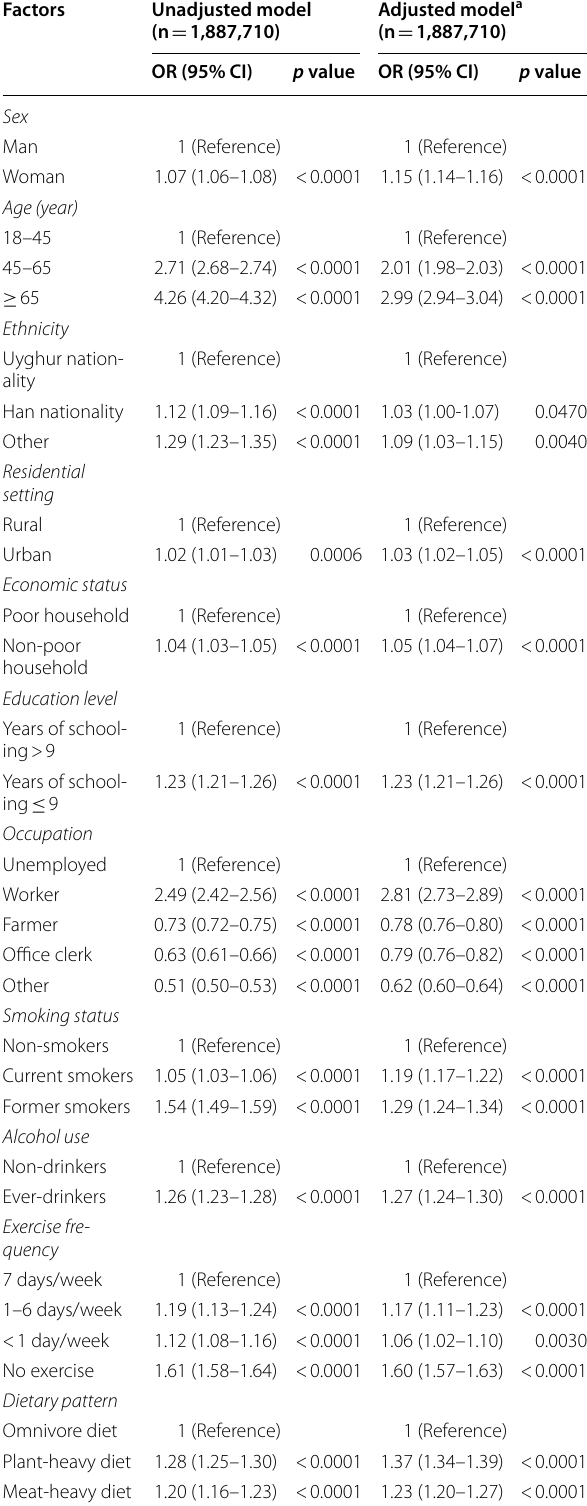
Table 2 Association between CVD and candidate factors in unadjusted models and adjusted model